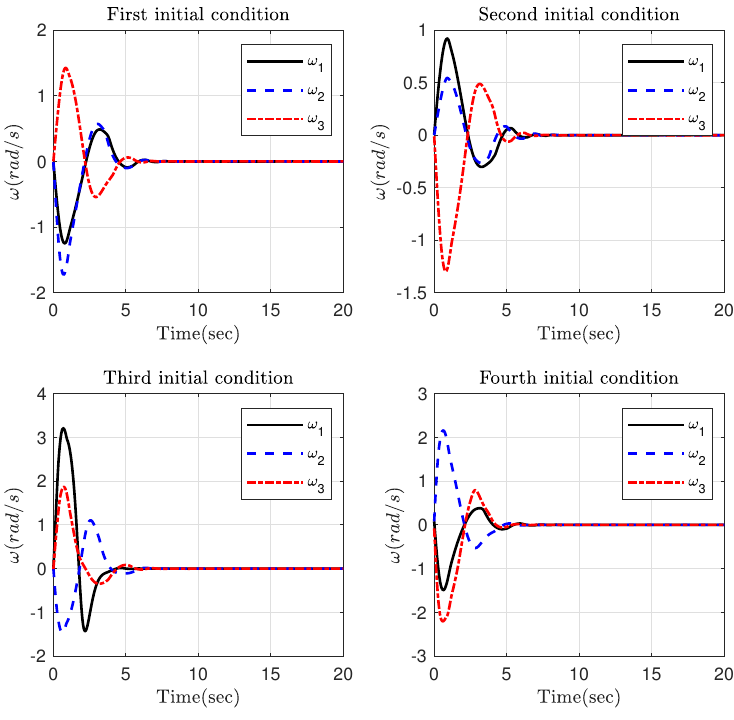
Figure 6. Time responses of the rotation velocity in Part 1 for different initial conditions.